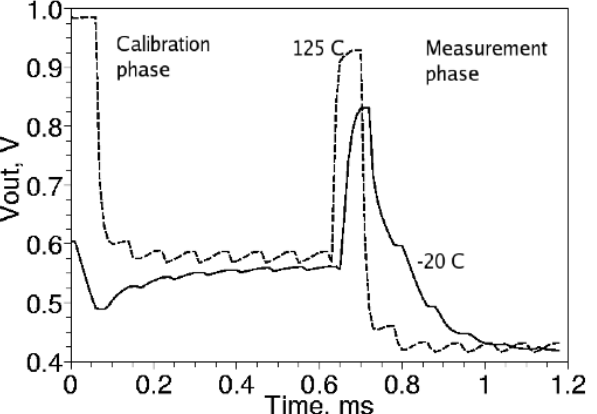
Figure 4. The simulated performance of the C-V converter at different